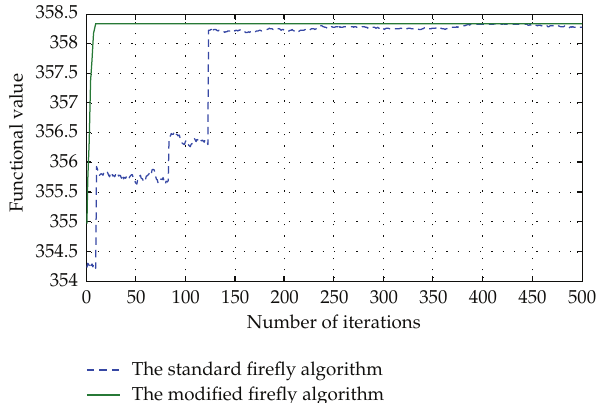
Figure 6: Simulation result of the sixth test problem.